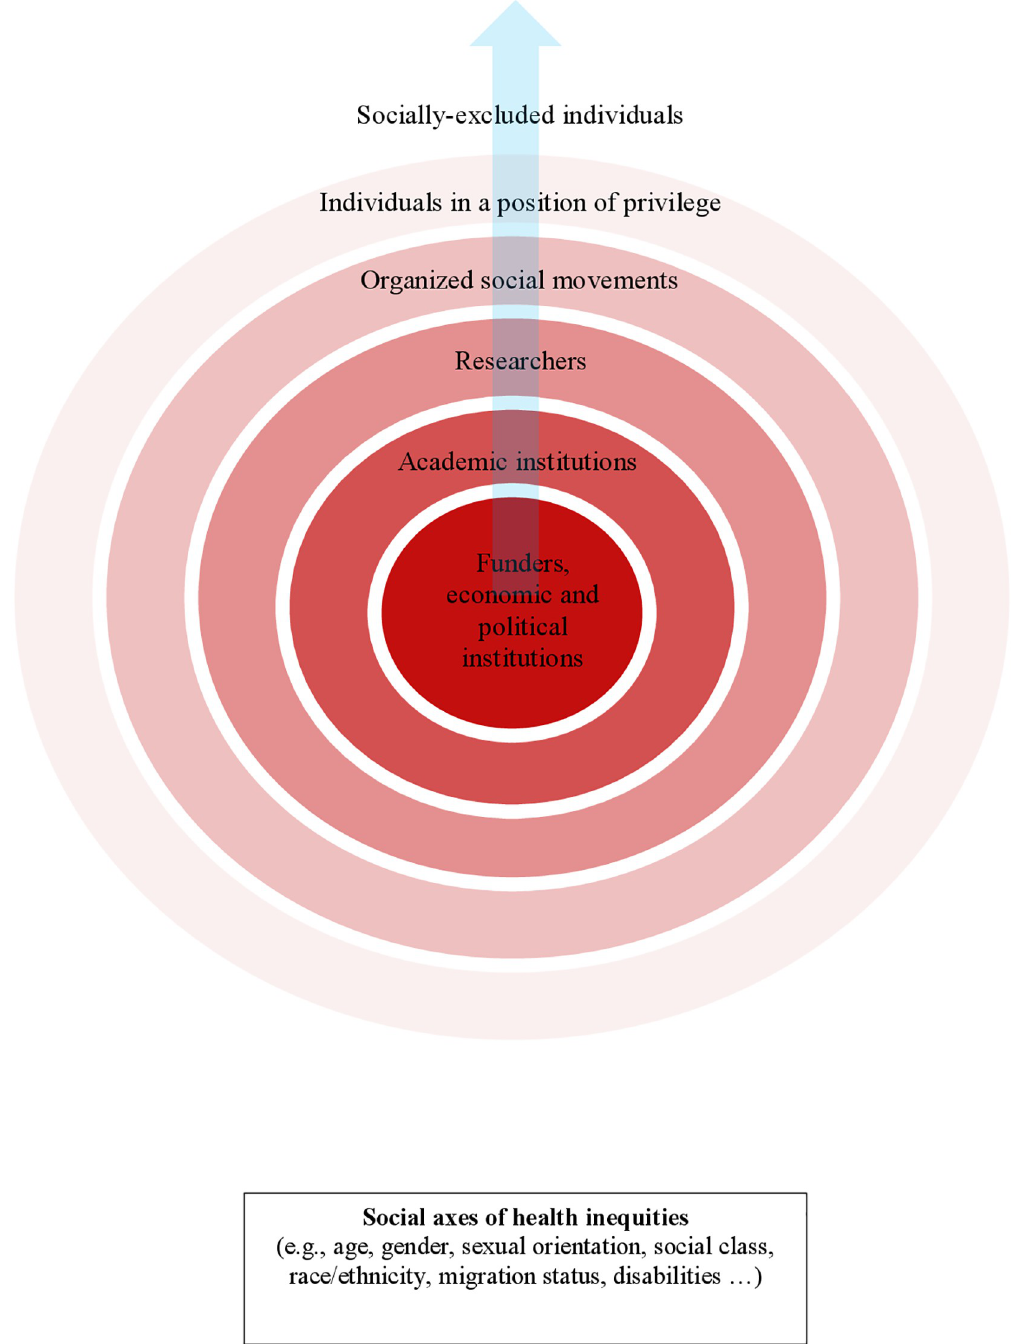
Fig 2. Power distribution of agents in public participation of scientific